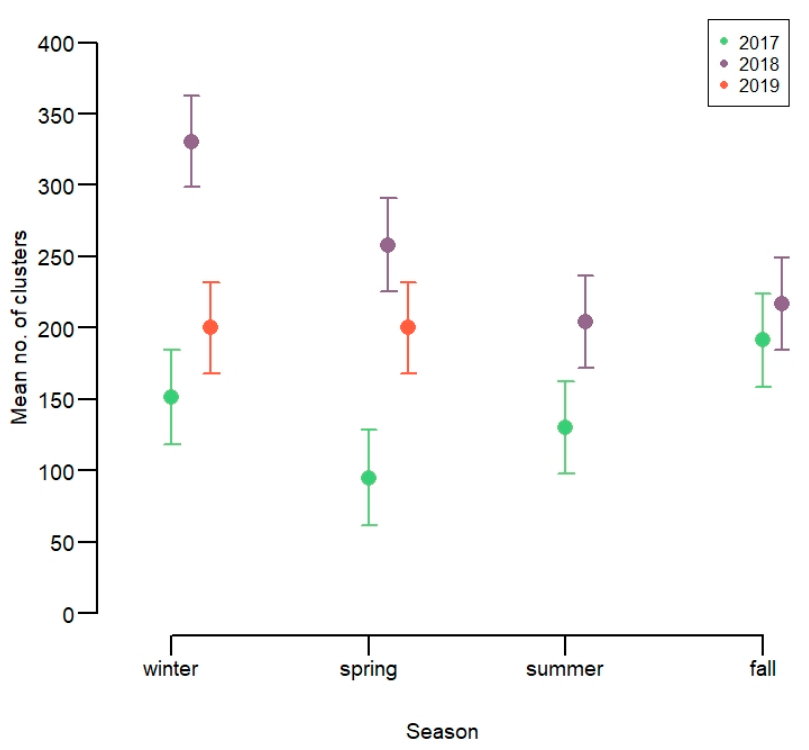
Figure 4. Number of spatial clusters of 13 GPS-marked red deer in Lærdal municipality, Norway. Animals 2021 , 11 , x FOR PEER REVIEW Number of revisits . The number of positions within a cluster averaged 12 GPS-posi- tions (given the 5 GPS-positions threshold), but was up to 93 positions. Only 2.9% of clus- ters had more than 50 GPS-positions, but this represented 8.3% of clusters in agricultural fields. The total number of fixes per individual and month was on average 696 and with a maximum possible of 744 for months with 31 days. The number of revisits was best explained by the interaction term between year, season and habitat (Table S5). The num- ber of revisits was higher in agricultural fields than in forest, and was much higher in 2018 than the other years, in particular during winter (Figure 5, Table S6).